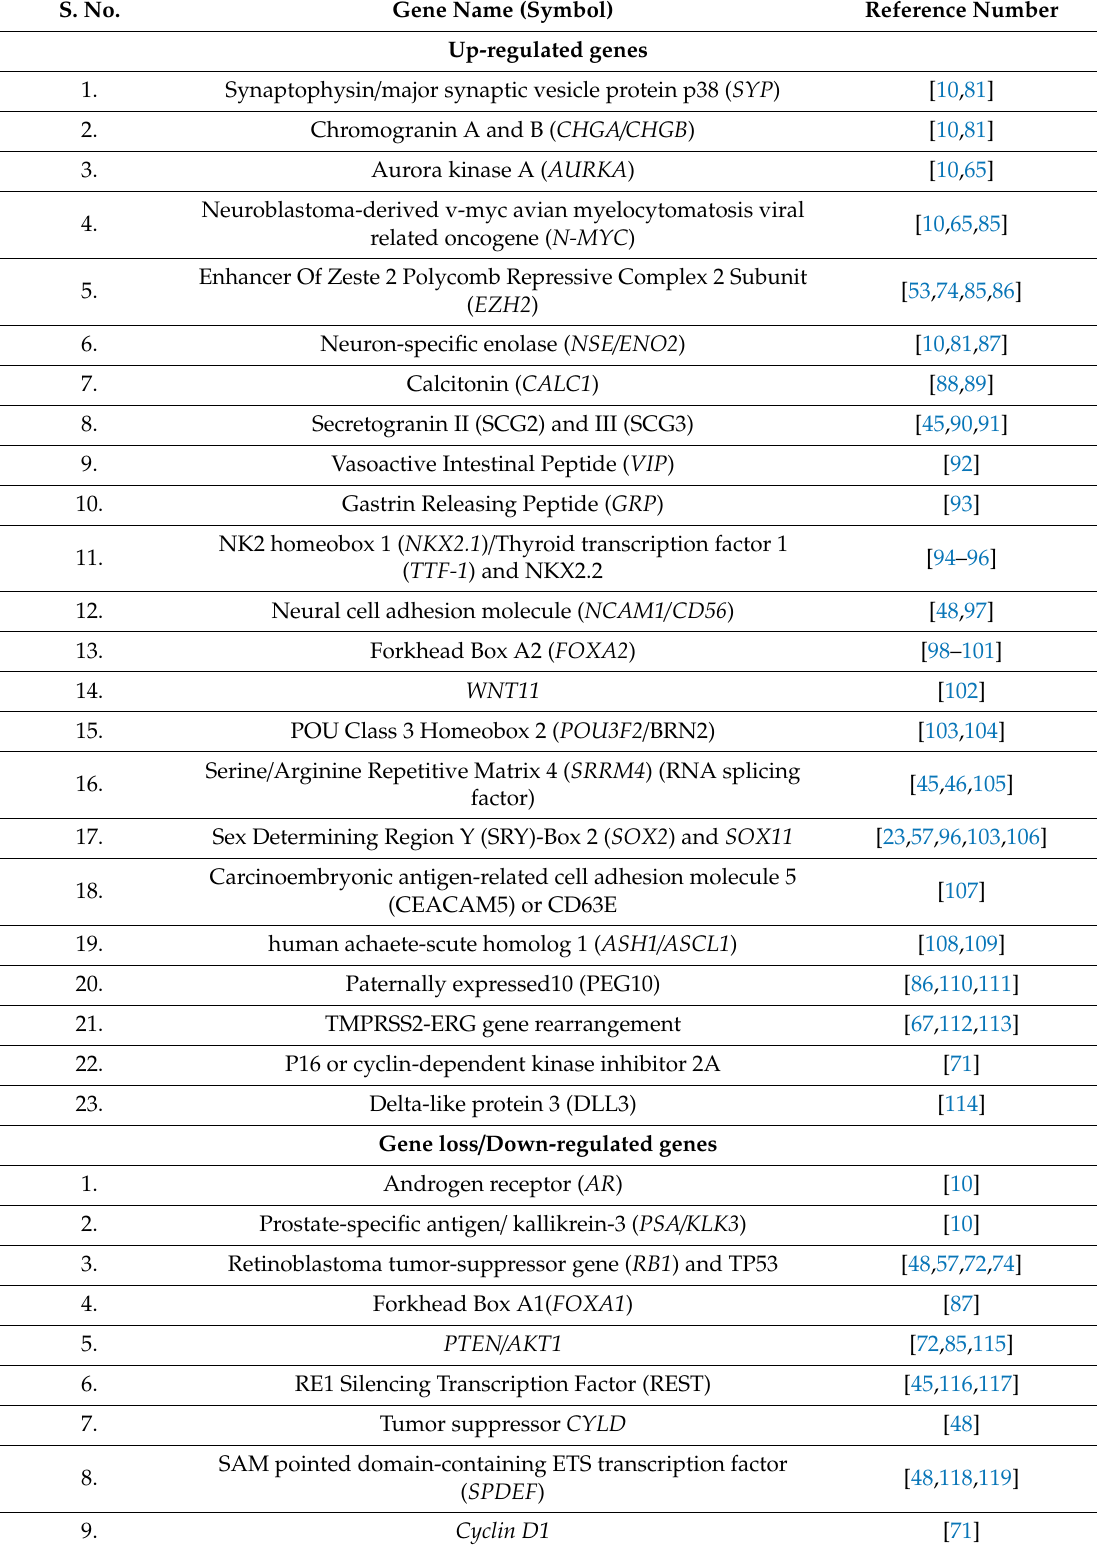
Table 2. List of proposed markers associated with neuroendocrine prostate cancer (NEPC). S.